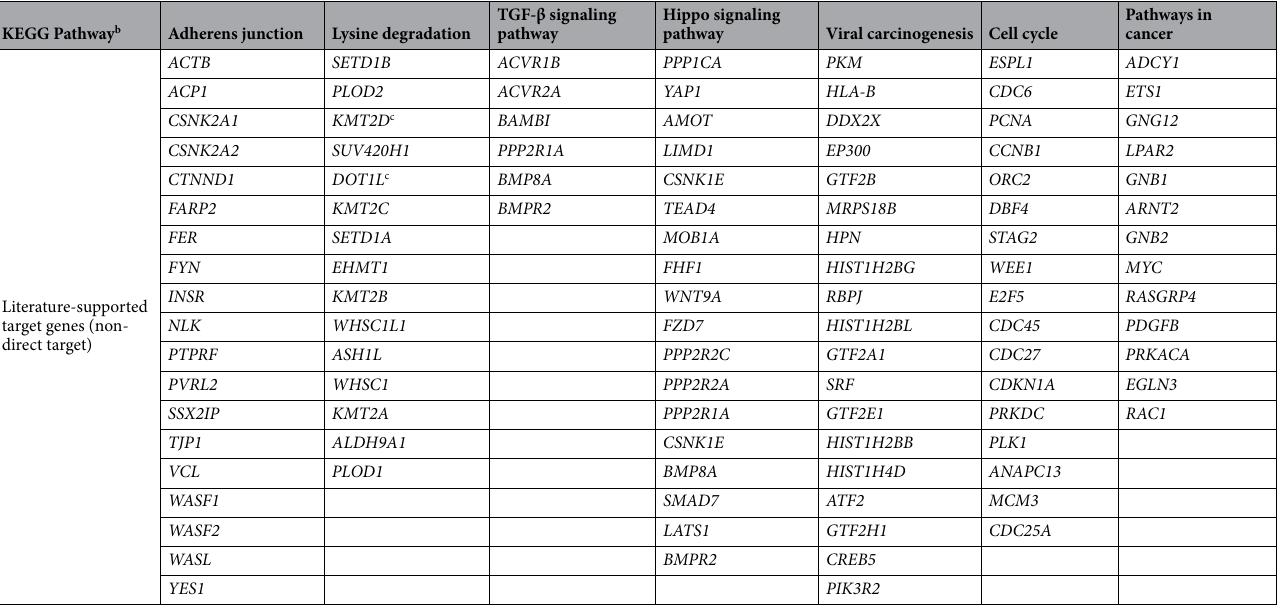
Table 4. Functional pathway analysis of predicted sequence and literature-based miR target genes. a KEGG pathways were identified based on TargetScan predicted miR target genes. b KEGG pathway analysis based on Tarbase v7.0 c Genes targeted by 2